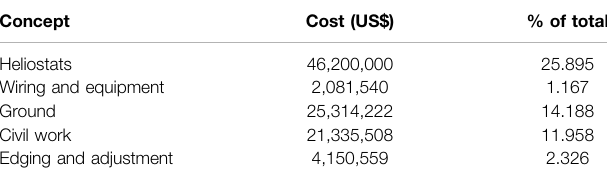
TABLE 1 | Cost involved in the solar power generation plants. Concept Cost (US$) % of